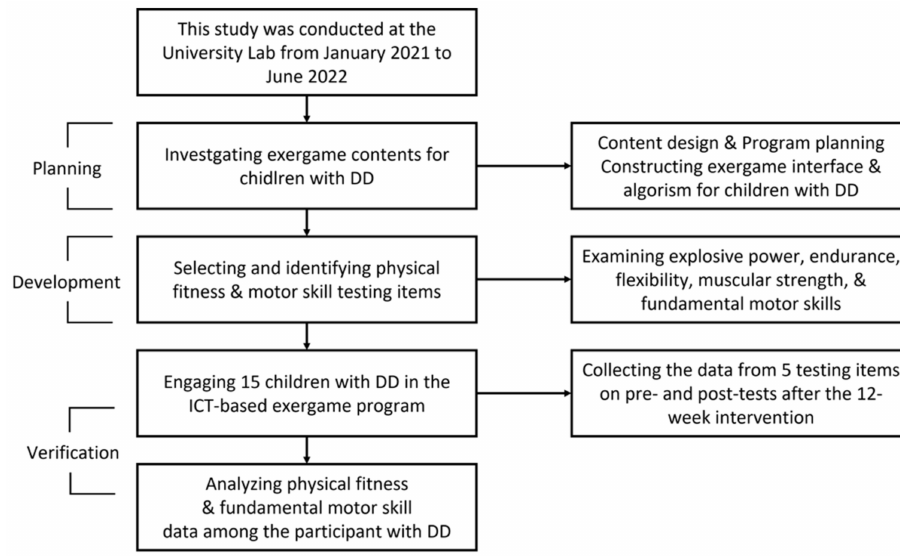
Figure 4. Flow chart of the